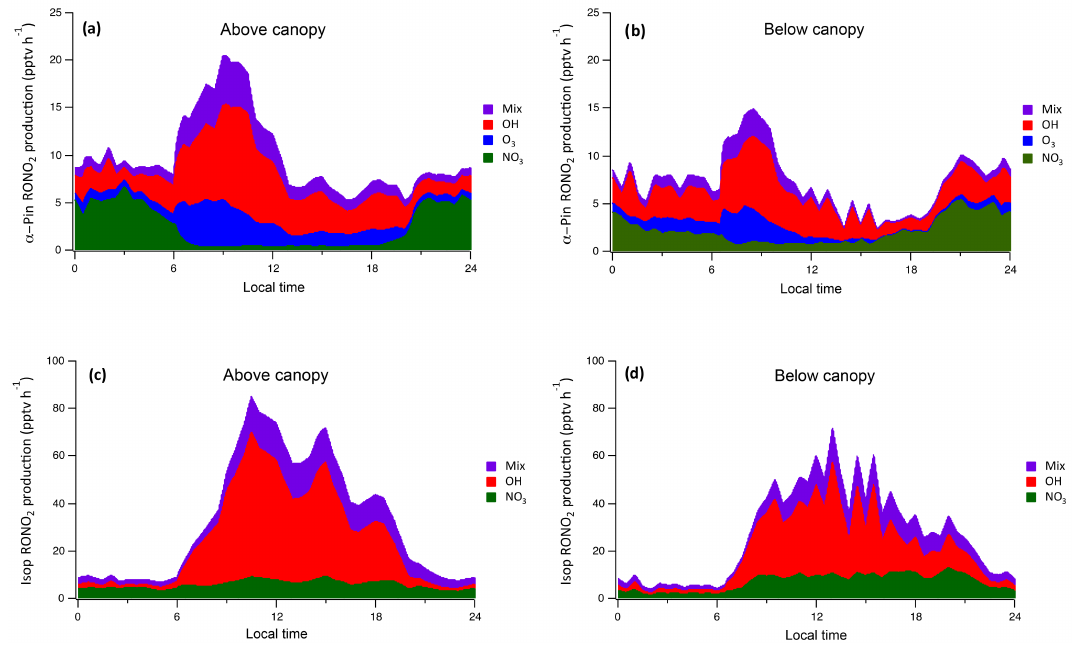
Figure 7. RONO 2 production through oxidation of (a) α -pinene above canopy, (b) α -pinene below canopy, (c) isoprene above canopy, and (d) isoprene below canopy by NO 3 , O 3 , OH, and a mix of oxidants. Each color represents the sum of the production rates of each RONO 2 species formed through initial oxidation of the parent VOC (isoprene or α -pinene) by the specified oxidant. The “Mix” category represents later-generation RONO 2 products formed through initial oxidation by NO 3 , O 3 , or OH followed by secondary oxidation by a different